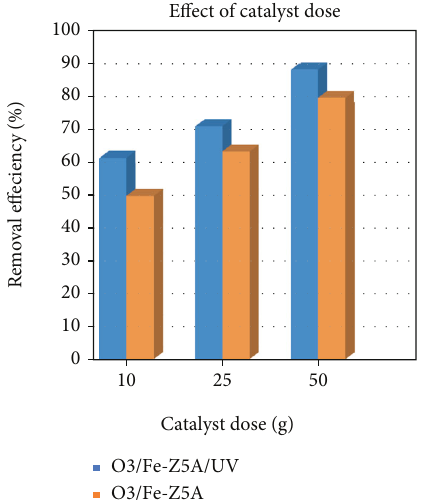
= 50 mg/L ; pH = 6 : 5 cipro Þ Figure 7: Catalyst dose e ff ect on cipro fl oxacin removal ( C o ð = 50mg/L ; pH = 6 : 5 ± 0 : 2 ; O cipro Þ catalyst dose = 10g , 25 g, and 50 g: T = 60 min ).